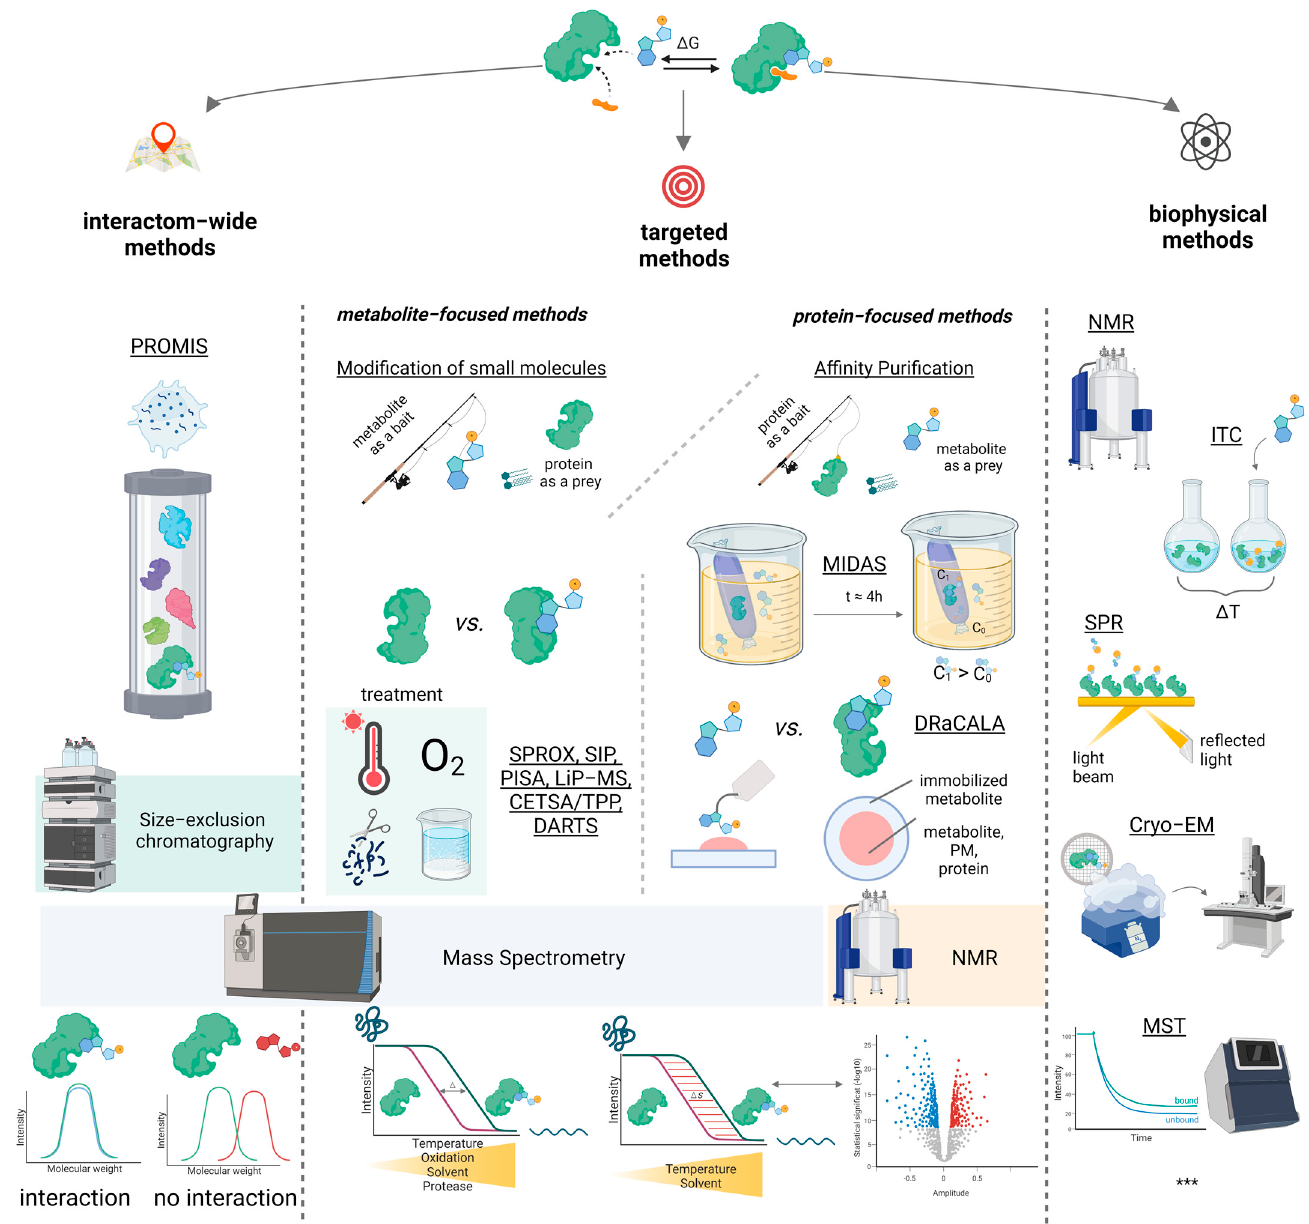
Figure 1. General classification of the type of interaction and challenges in protein – metabolite Figure 2. Schematic overview of the classification used in the review and the approaches for studying interactomics. protein–metabolite interactions discussed in the text. Generally, the approaches are metabolite- focused, protein-focused, interactome-wide, biophysical. A detailed description of these methods (as well as the methods not shown in the illustration, ***) is presented